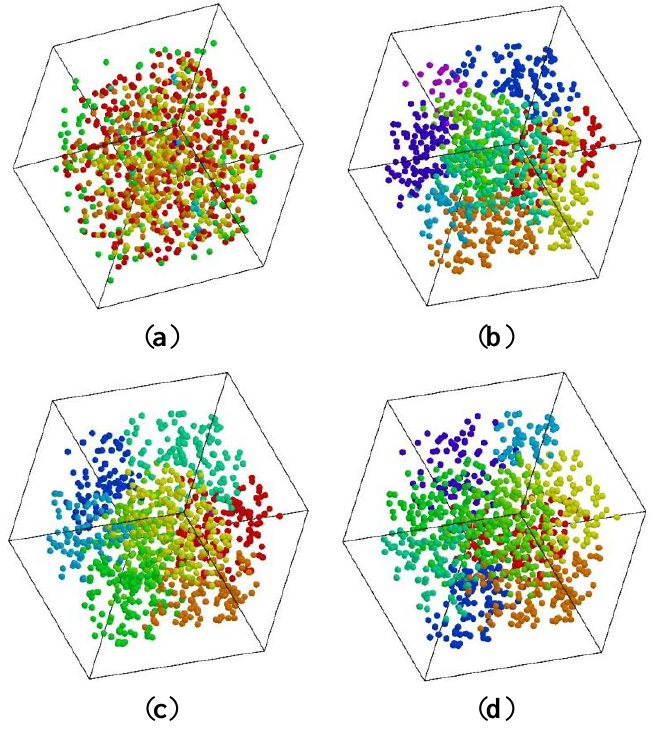
Figure 5. Different patterns according to different importance values: ( a ) surface area. ( b ) neighborhood and distance; ( c ) neighborhood + distance + volume; ( d ) neighborhood + distance + surface